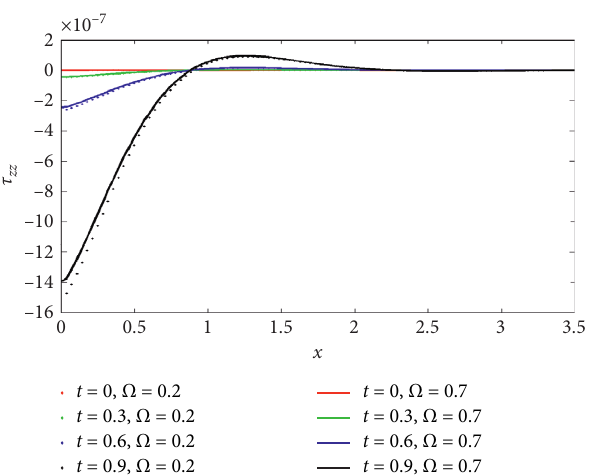
Figure 23: Stress τ x with laser pulse “ t ” and rotation. zz concerning